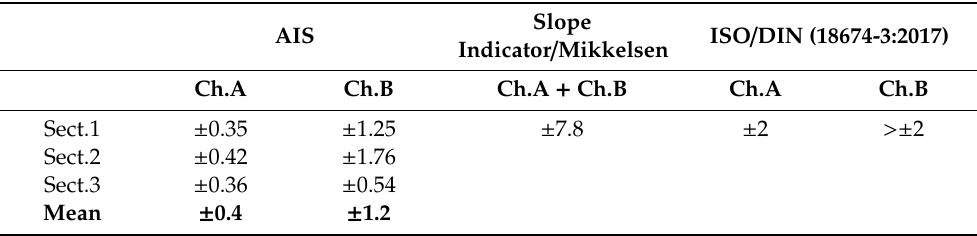
Figure 16. Cumulative displacements (and coupled standard deviation) as a function of the length of the borehole for the three sections observed. Table 7. Repeatability comparison in millimeters over a 30 m tube length between the robotic system and literature for manual measurements and